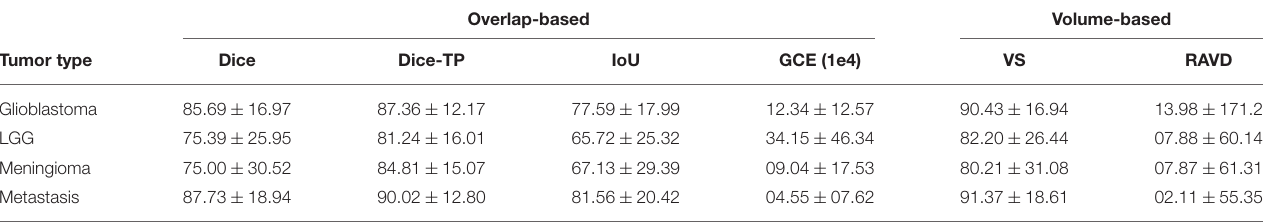
TABLE 5 | Voxel-wise performance summary for each tumor type for overlap-based and volume-based metrics.